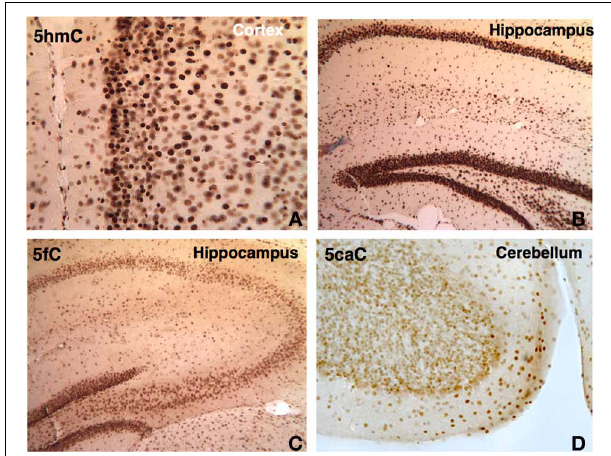
FIGURE 9 | DNA methylation intermediates were observed to be persistent throughout the life in the brain. A few examples are shown here. The 5hmC persists in the cortex (A) and hippocampus (B) in 1 year-old brain. The demethylated cytosine marks also prevailed. The 5fC is shown in the hippocampus at P21 (C) , and 5caC (D) in cerebellum at